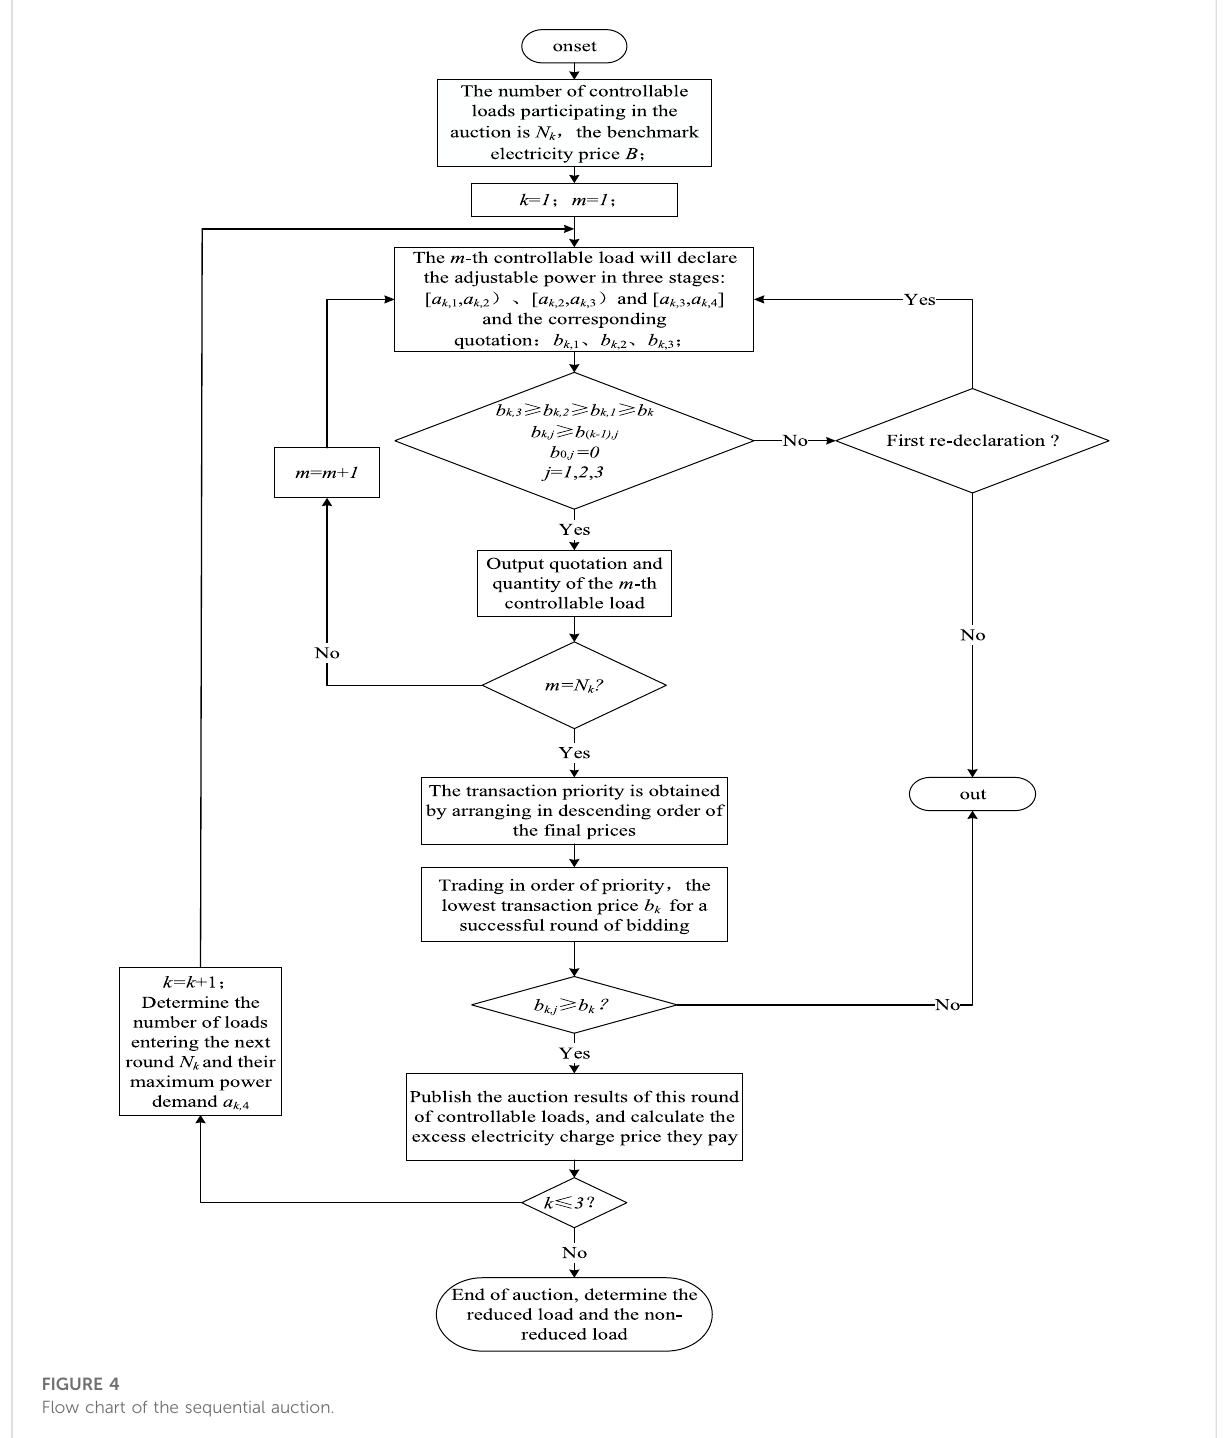
FIGURE 4 Flow chart of the sequential